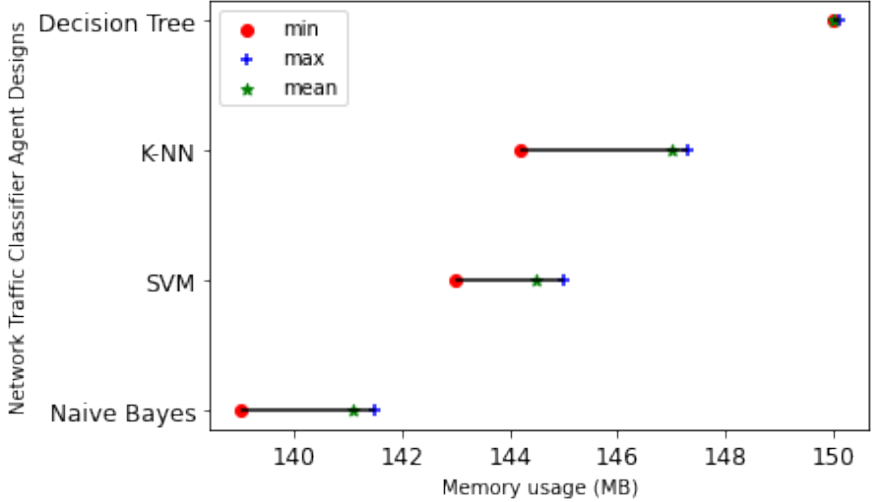
Figure 17. Comparison of NTCA memory